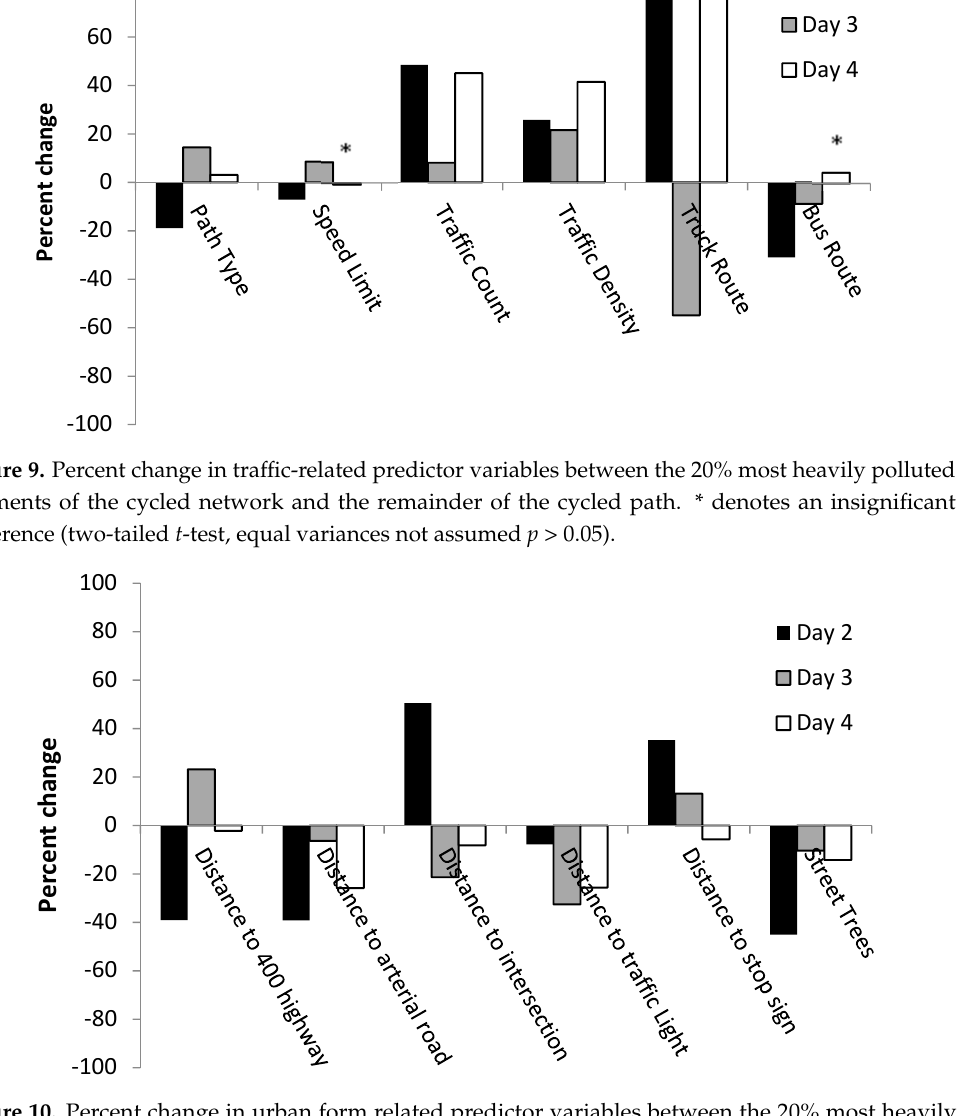
Figure 10. Percent change in urban form related predictor variables between the 20% most heavily polluted segments of the cycled network and the remained of the cycled path.